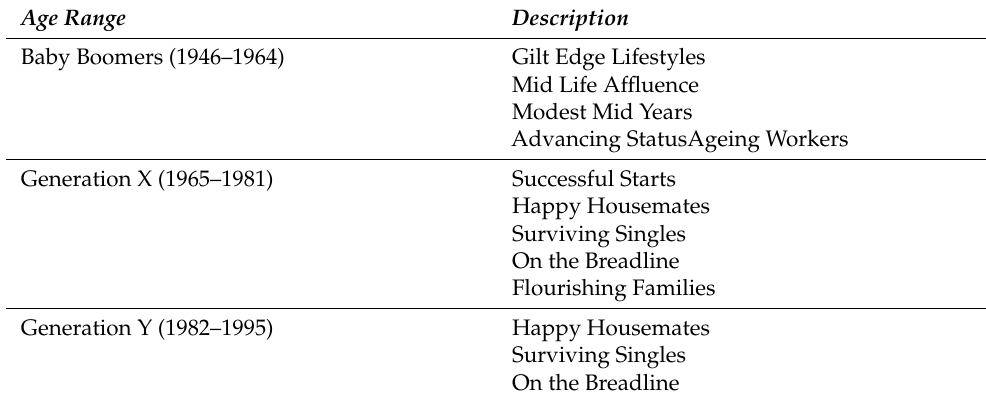
Table 1. Age-based networks. Source: www.experian.co.uk (accessed on 9 May